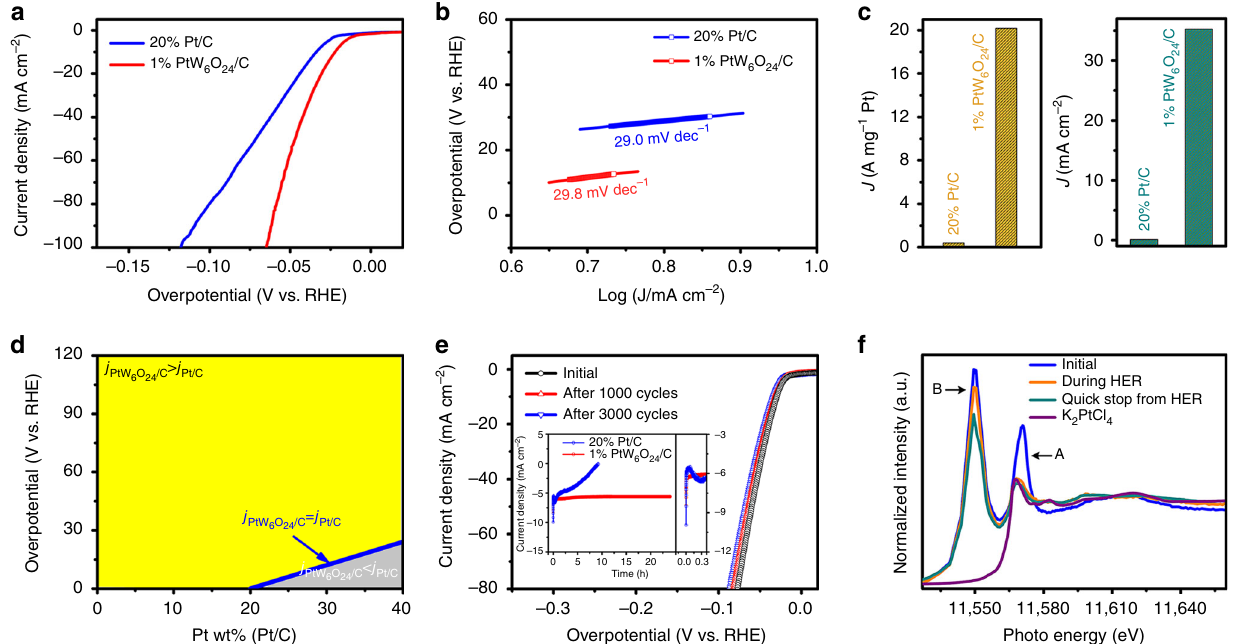
Fig. 2 HER performance of the PtW 6 O 24 catalyst. a The polarization curves of 1% PtW 6 O 24 /C and 20% Pt/C in N 2 -saturated 0.5 M H 2 SO 4 . b Tafel slope of 1% PtW 6 O 24 /C and 20% Pt/C. c Mass activity of PtW 6 O 24 /C and 20% Pt/C at 77 mV (left), the speci fi c activity of 1% PtW 6 O 24 /C and 20% Pt/C at 50 mV (right). d The relationship between the current density, the overpotential, and the Pt content. The blue area indicates that the current density of PtW 6 O 24 /C and 20% Pt/C is the same. The yellow area indicates that the current density of PtW 6 O 24 /C is greater than Pt/C, and the gray area indicates that the current density of PtW 6 O 24 /C is lower than Pt/C. e The polarization curves of 1% PtW 6 O 24 /C before and after 1000 and 3000 cycles at scan rate of 5 mV s − 1 . Inset: Time-dependent current density current of 1% PtW 6 O 24 /C and 20% Pt/C within 24 h (left). The locally enlarged plot of the time- dependent current density current for the fi rst 0.5 h (right). f In situ XANES spectra of the 1% PtW 6 O 24 /C sample at Pt L 3 -edge. Feature A is attributed to Pt L 3 -edge and feature B is attributed to W L 2